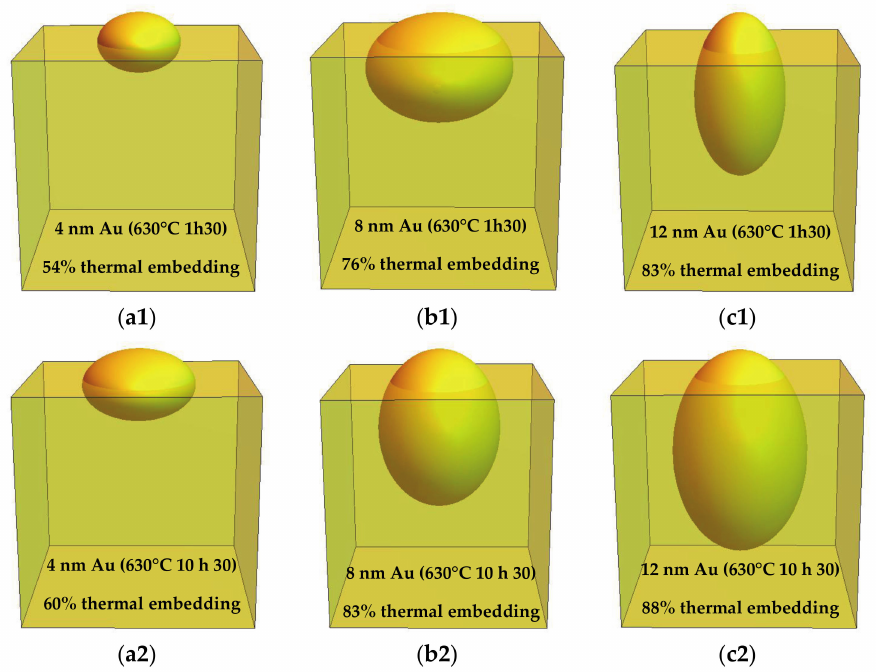
Figure 3. Representative 3D drawing of each sample’s microstructure after thermal annealing treatments at 630 ◦ C: ( a1 ) 4 nm Au annealed for 1 h 30; ( b1 ) 8 nm Au annealed for 1 h 30; ( c1 ) 12 nm Au annealed for 1 h 30; ( a2 ) 4 nm Au annealed for 10 h 30; ( b2 ) 8 nm Au annealed for 10 h 30; ( c2 ) 12 nm Au annealed for 10 h 30. Ellipsoids were used as an approximation for the Au NPs’ shape. The edges of the cubes, representing the glass substrates, measure 100 nm in length. The formation of a glass rim surrounding the NPs is not accounted for in these